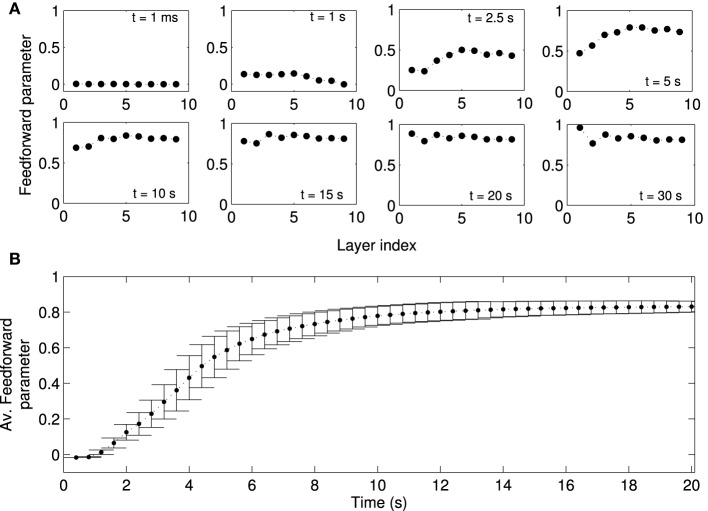
Formation of a feed-forward structure in locally connected networks. Local excitation drives STDP in the network such that synapses from lower to higher layers become strengthened, while the synapses in the reverse direction are weakened. Note that “layers” in our study refers to abstract layers based on synaptic distance to high frequency neurons (Figure 1C). We do not manually set up a feedforward structure in our network. (A) The feedforward parameter as a function of the layer is shown at different times (same as Figure 5B) for one representative network simulation. Initially, the feed-forward parameters are close to zero because the initial synaptic weights are symmetric. Values of the feedforward parameter near 1 indicate a feedforward structure. Due to plasticity the feedforward structure emerges gradually in the network, first in higher layers (t = 5 s) and later in the lower layers. (B) Feedforward parameter as a function of simulation time averaged across 50 simulations with different random input currents. There are no apparent changes in the structure of the network after t = 20 s. Errorbars show the standard deviation (SD) at each timepoint. Note that the SD decreases as the weights reach the steady state.